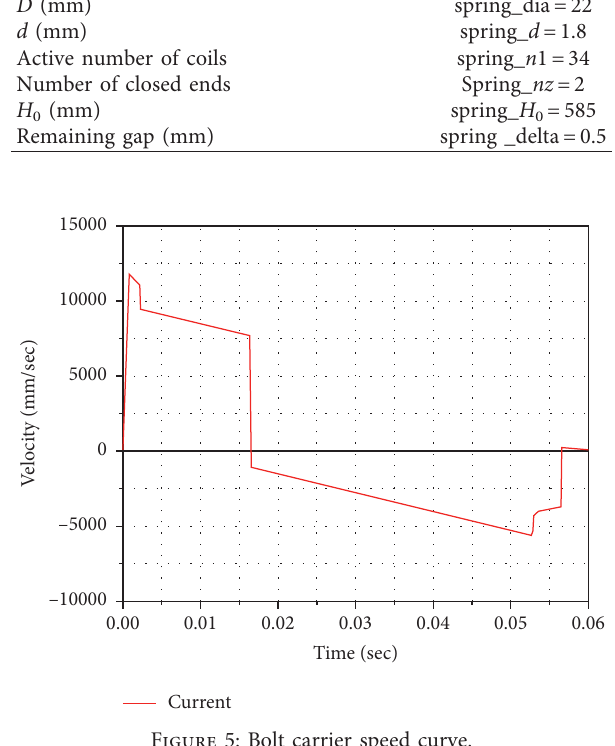
Figure 5: Bolt carrier speed curve.